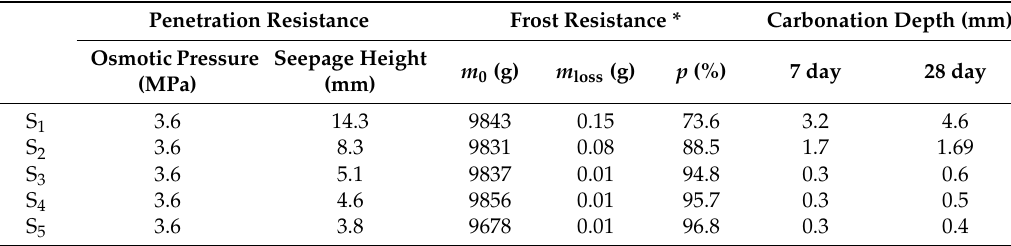
Table 5. Cement composite durability testing